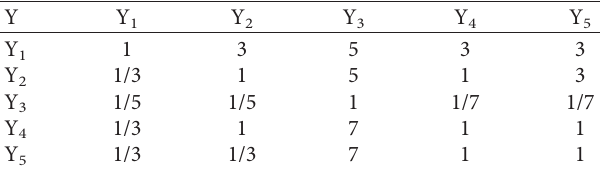
Table 4: Level I index judgment matrix on the comprehensive cost factor of prefabricated decoration.